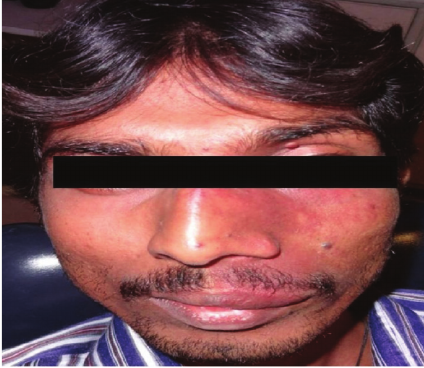
Figure 5: Extraoral view showing port-wine stain on the left side of the face.